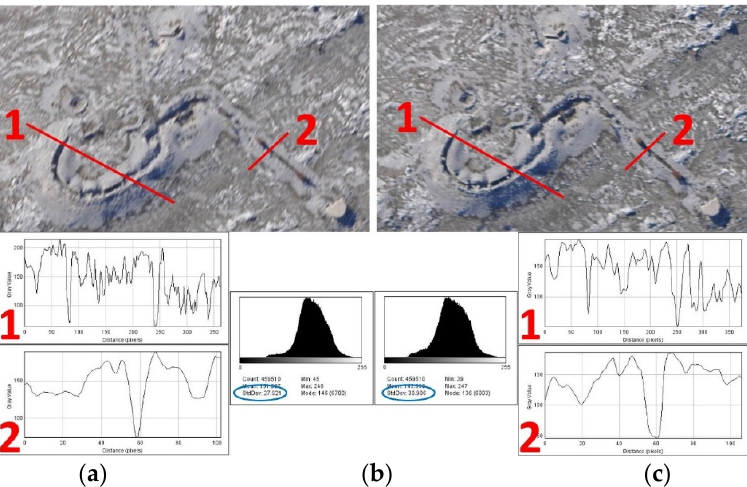
Figure 10. ( a ) Vibration phases: AB engines off, BCD engines on, EF increase power and take off, > F flight; ( b ) the diagram shows the speed (velocity, m/s) and acceleration dependence on the X , Y and Z axes (ACCS_X, ACCS_Y, ACCS_Z, m/s²) in relation to the number of samples. Speed was calculated based on data from the GPS receiver with a frequency of 1 Hz, and acceleration was read from iMAR deviation (27.921 without isolators v.s 30.906 with isolators, Figure 11). When vibration isolators were with a frequency of 20 Hz on the measured platform accelerations per axis: ( c ) X axis, ( d ) Y axis and disabled, zooming two or three times made the images blurred. ( e ) Z axis.